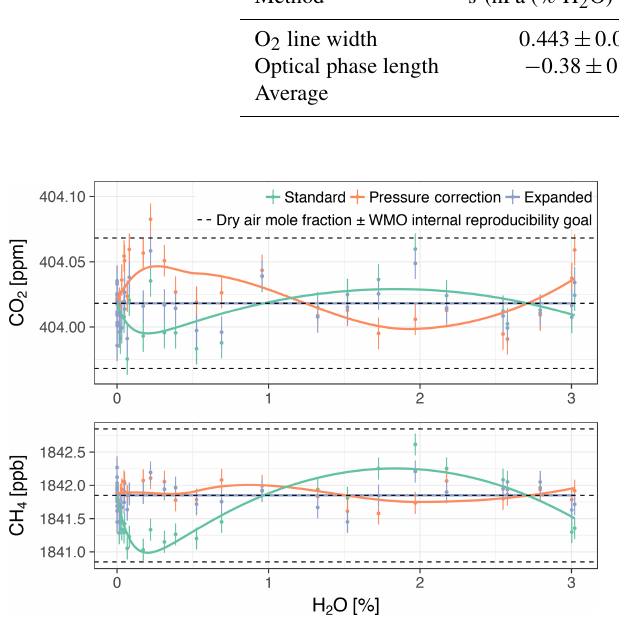
Figure 7. Dry air mole fractions from the experiment with Picarro no. 3 based on the standard water correction model, pressure cor- rection model (i.e., using independently measured cavity pressure), and expanded water correction model (i.e., using the empirical de- pendence of cavity pressure on water vapor). Error bars show 1 standard deviation of the trace gas mole fractions measured in dry air. The solid lines are the biases of the models assuming the ex- panded model was unbiased (smoothed for the pressure correction model), offset by the mole fractions measured in dry air. The up- per and lower dashed lines correspond to the WMO internal repro- ducibility goals (see Sect. 3.4.1), in the case of CO 2 in the Northern Hemisphere (WMO, 2016).